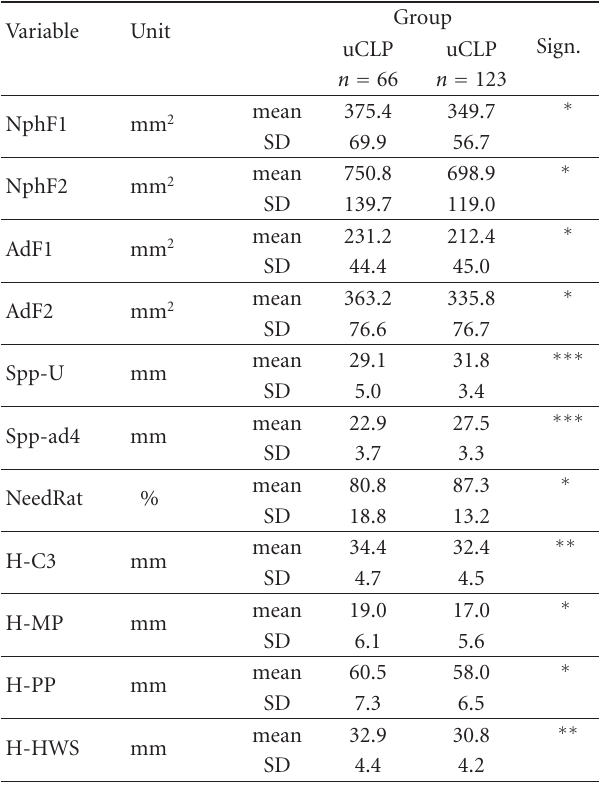
Table 5: Significant di ff erences between uCLP and control group in